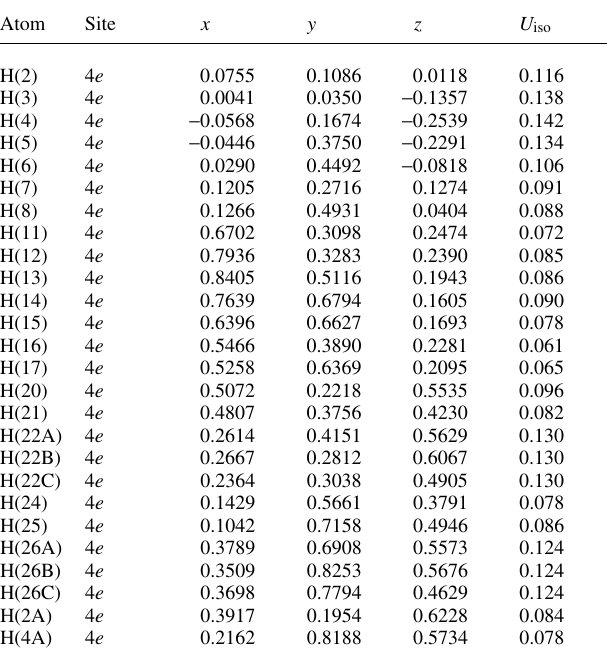
Table 2. Atomic coordinates and displacement parameters (in Å 2 )